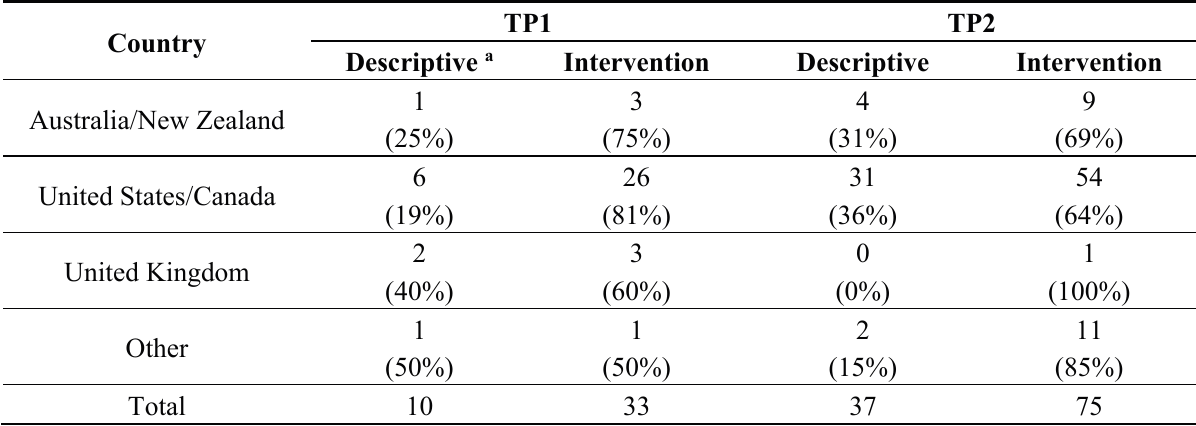
Table 1. Research output by country, publication type and time period represented by number of publications and proportion (%) output. TP1 TP2 Country Descriptive a Intervention Descriptive